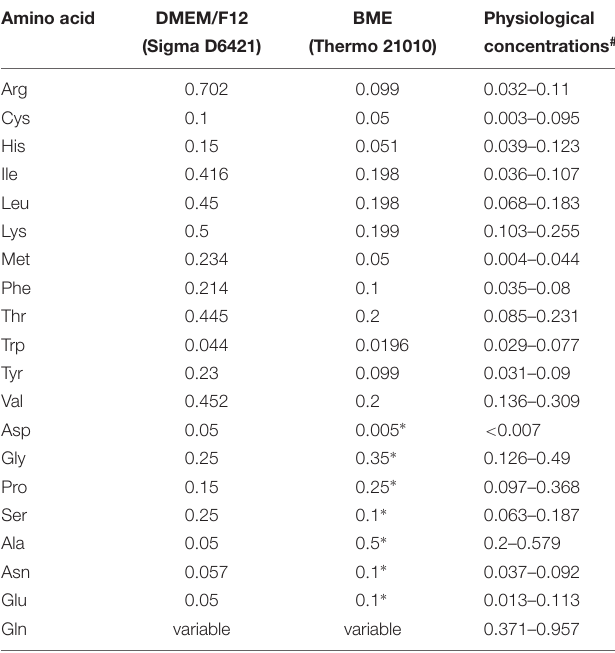
∗ AAs added to the media at the final concentration indicated in the table. # Physiological plasma concentration adult, fasting (Mayo Clinic, Quantitative AA- Analysis). Glutamine was added to the media at the concentration